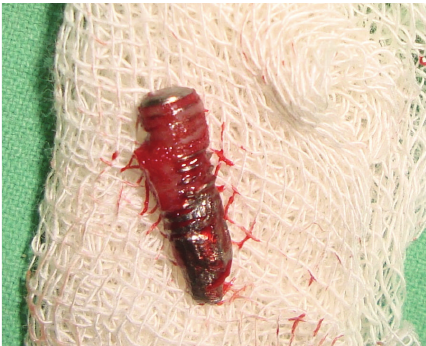
Figure 3: Implant placed at mandibular left second bicuspid region.